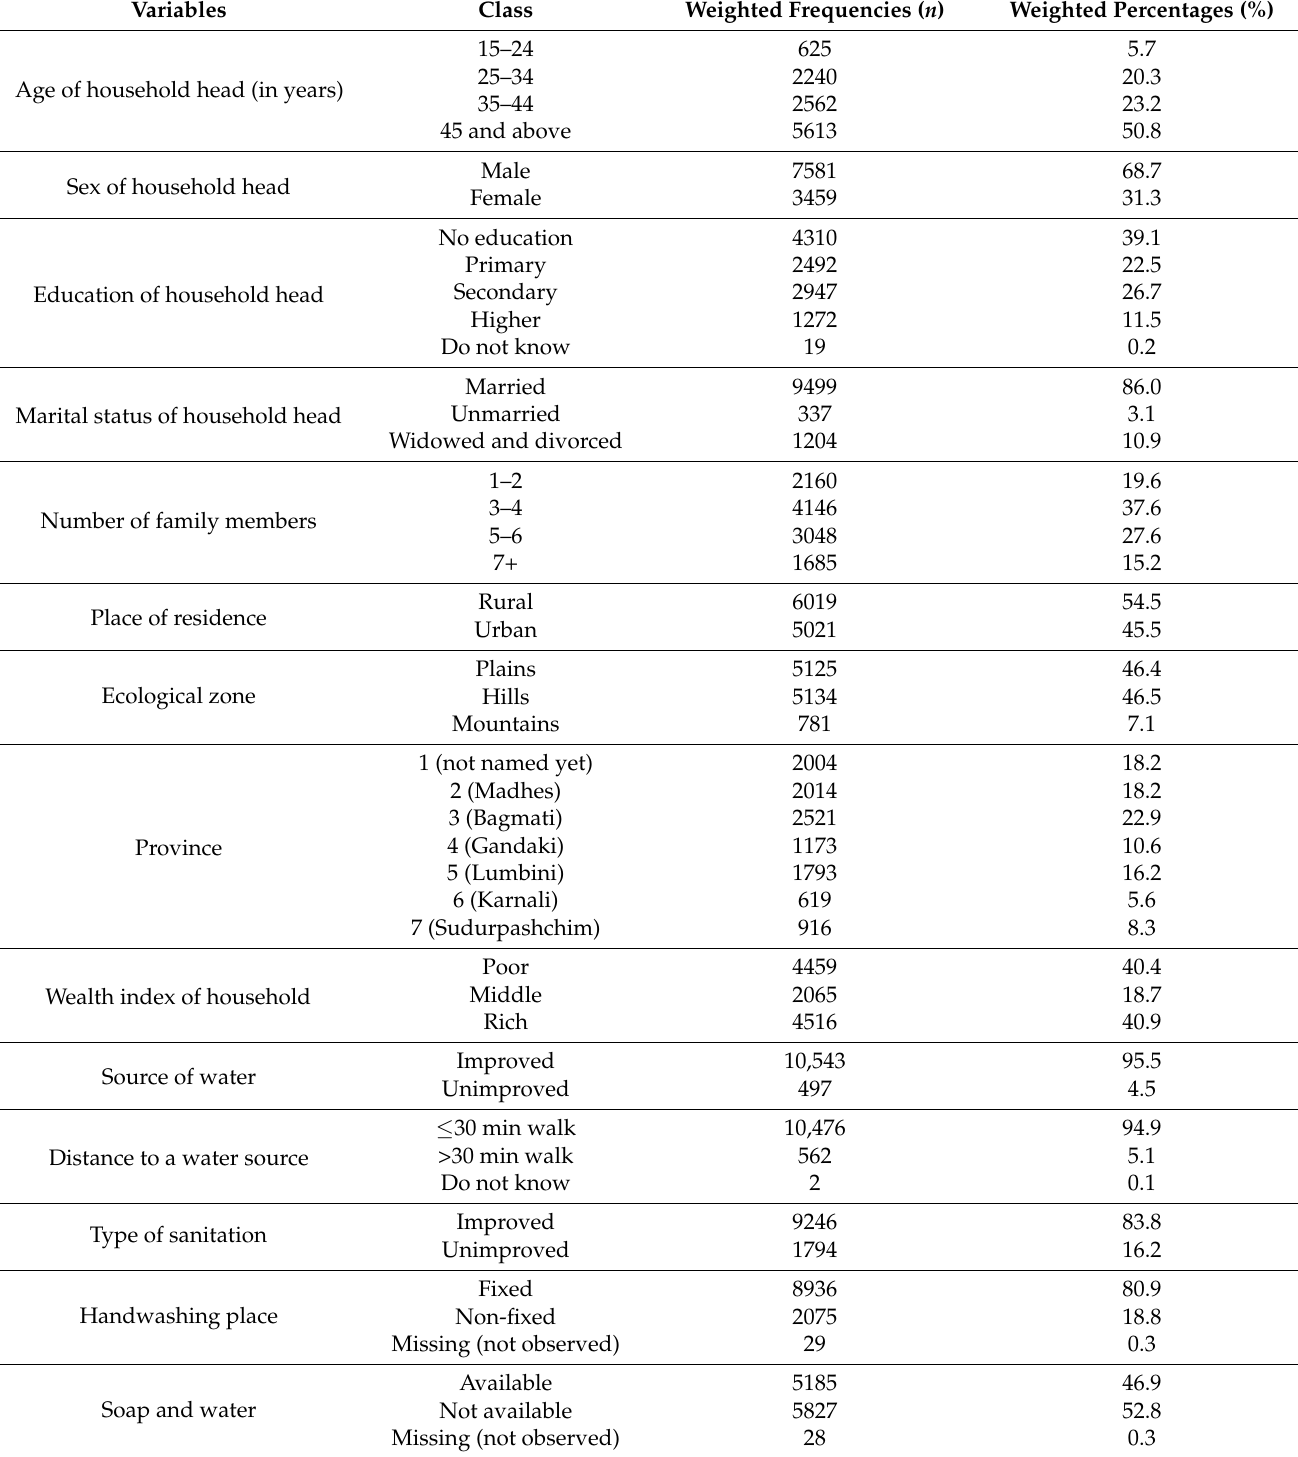
Table 2. Socio-demographic and WASH characteristics of respondents ( n =